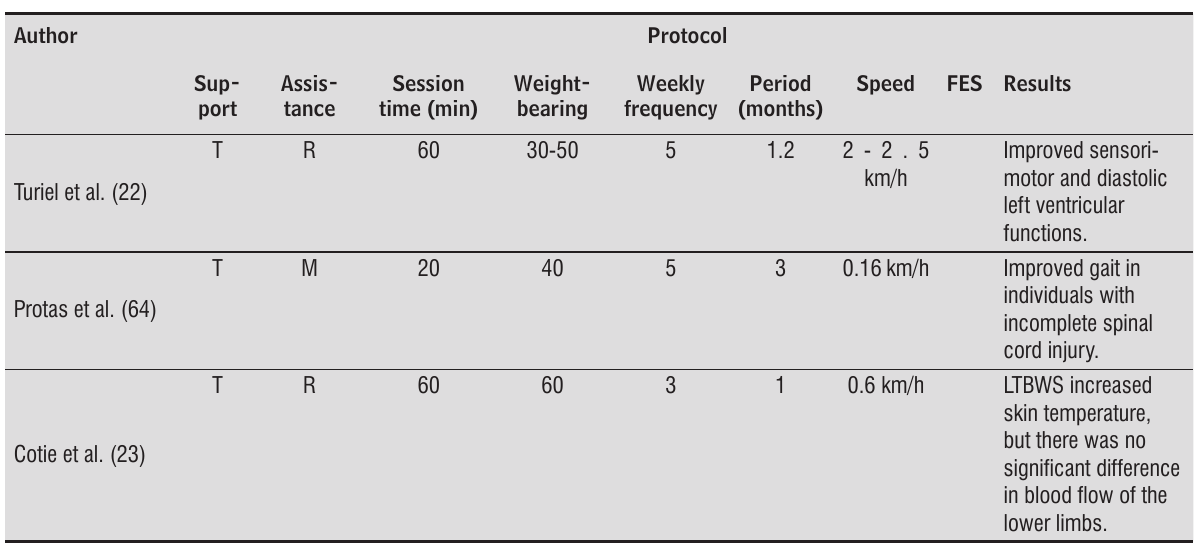
Table 2 - LTBWS protocols and their respective